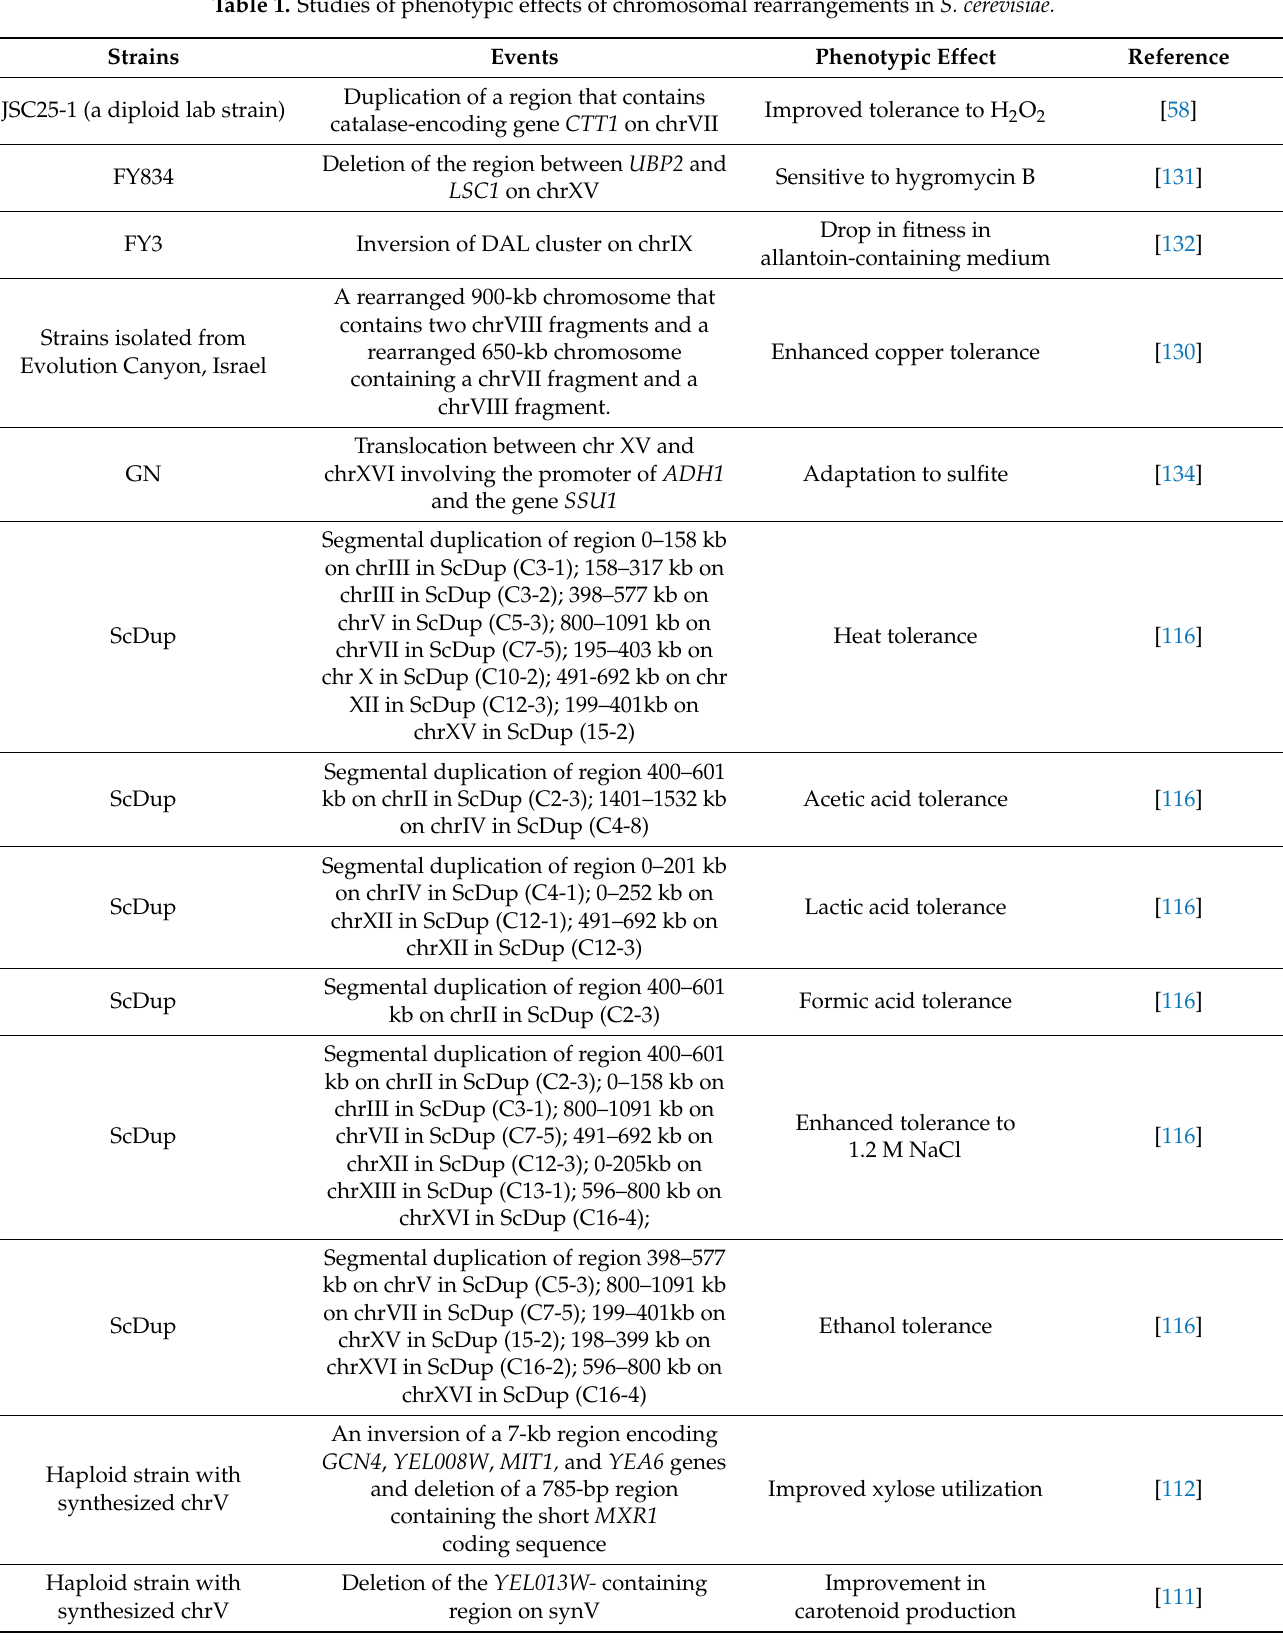
Table 1. Studies of phenotypic effects of chromosomal rearrangements in S.